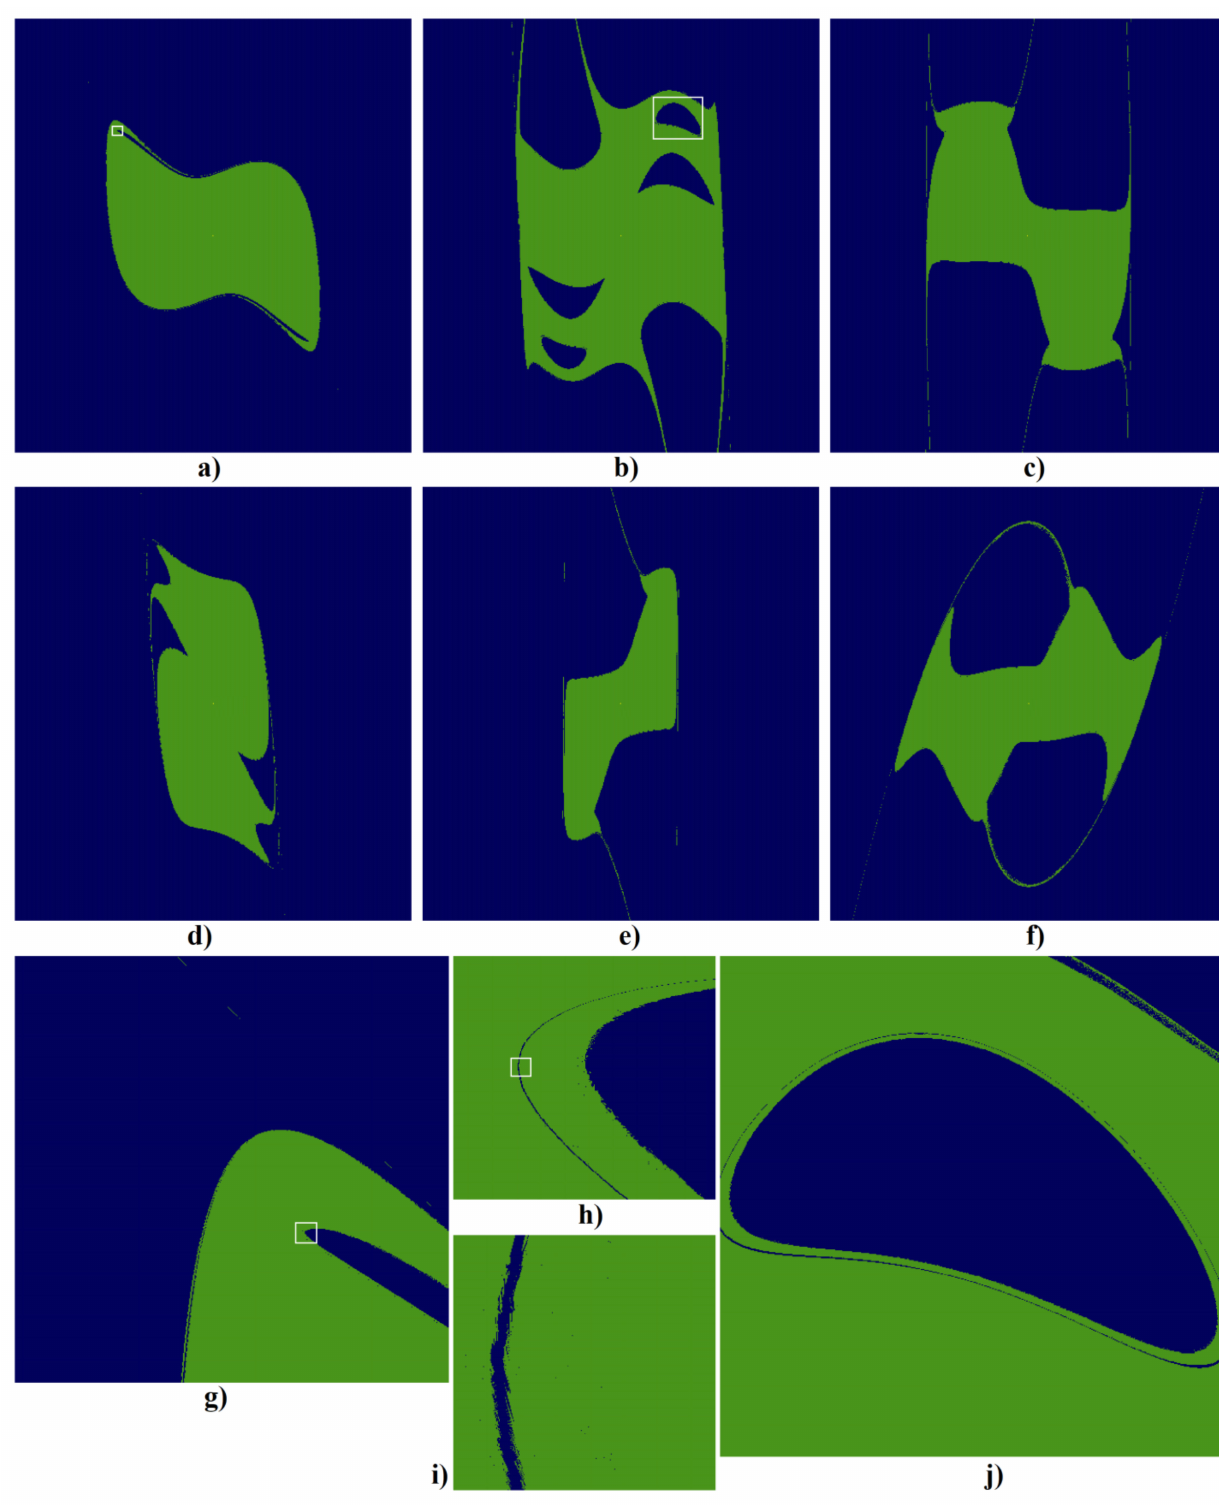
Figure 5. Cascoded resonant amplifier assumed as fourth order dynamical system. Colored basins of attraction, the plane fragments are defined as: ( a ) v 1 vs. v 2 , ( b ) v 1 vs. v 3 , ( c ) v 1 vs. i L , ( d ) v 2 vs. v 3 , ( e ) v 2 vs. i L , and ( f ) v 3 vs. i L . The rest of plots represent zoomed areas focused on